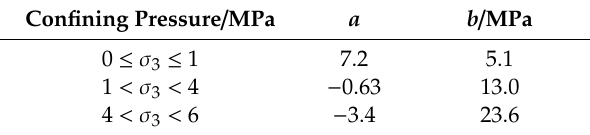
Figure 7. Compressive strength vs. confining pressure of coal samples under varied confining pressures after 3 cycles of liquid nitrogen injection. Table 5. Values of parameters a and b in the Equation